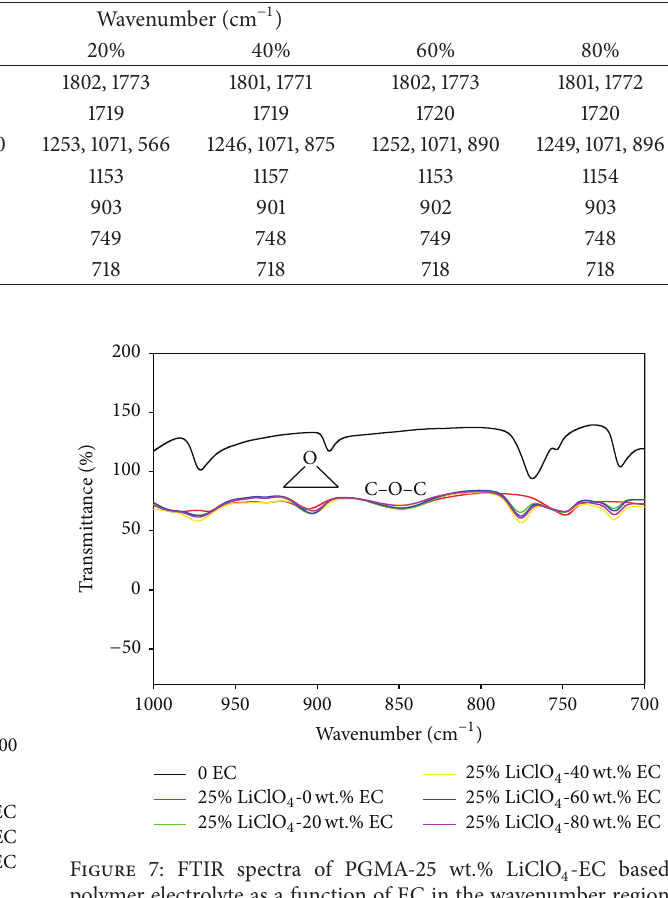
Figure 6: FTIR spectra of PGMA-25 wt.% LiClO 4 -EC based polymer electrolyte as a function of EC in the wavenumber region 1500–1000 cm −1 .